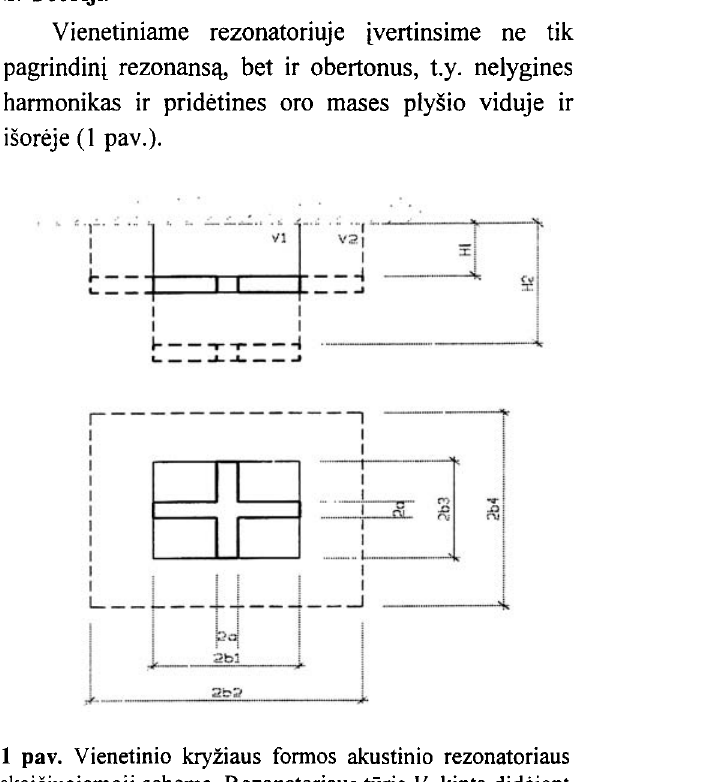
Fig 1. The calculation diagram of an isolated cross-shaped acoustic resonator. The resonator volume V changes along 1 with the increase in its height H and the resonator volume 1 V 2 changes along with the increase in its width 2a2 Vienetinio kryziaus formos akustinio rezonatoriaus garso absorbcija apskaiciuojama pagal formul~: